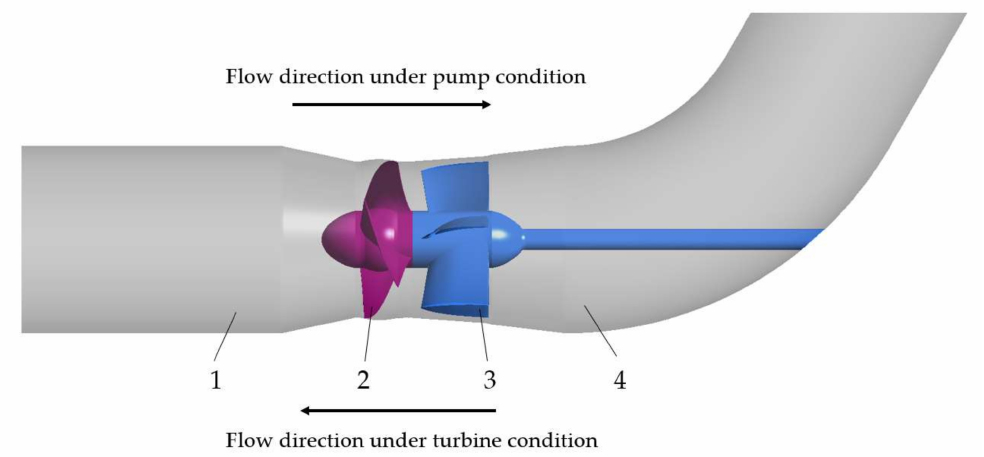
Figure 1. Three-dimensional model of axial-flow pump. 1—inlet passage; 2—impeller; 3—guide vane; 4—outlet